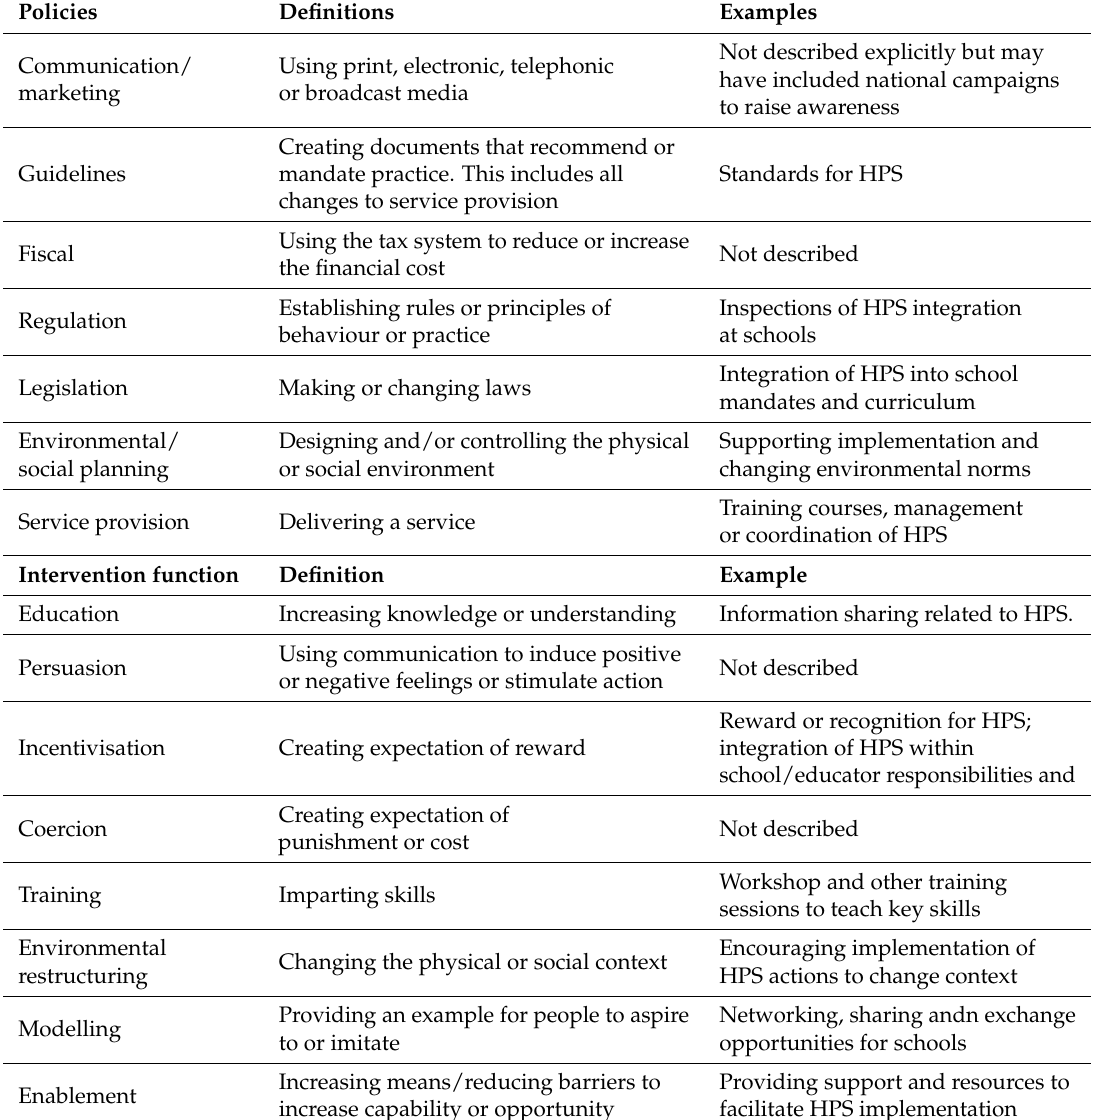
Table 1. Definitions and examples of intervention functions and policy categories with examples from this review relevant for a HPS approach (adapted from Michie and colleagues